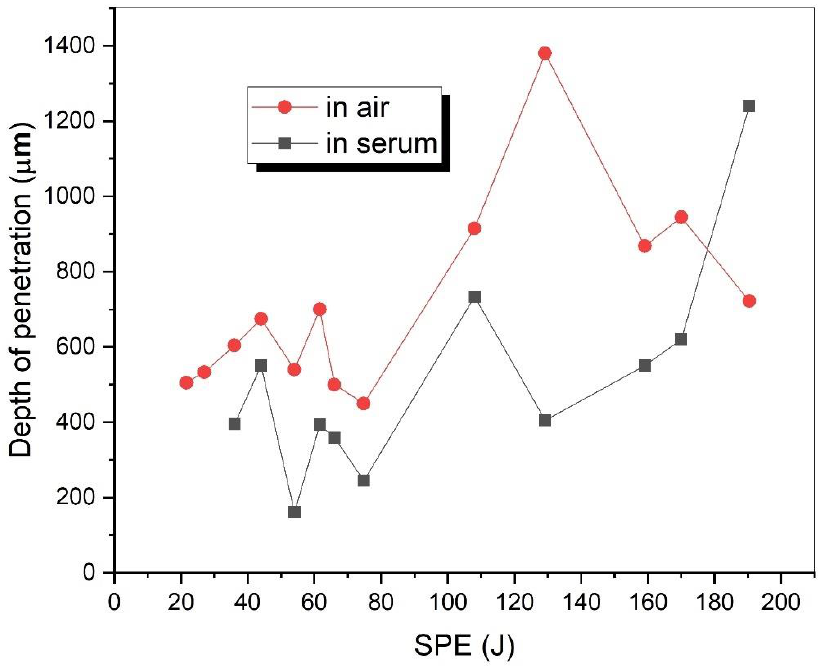
Figure 6. The relationship between the penetration depth and SPE .